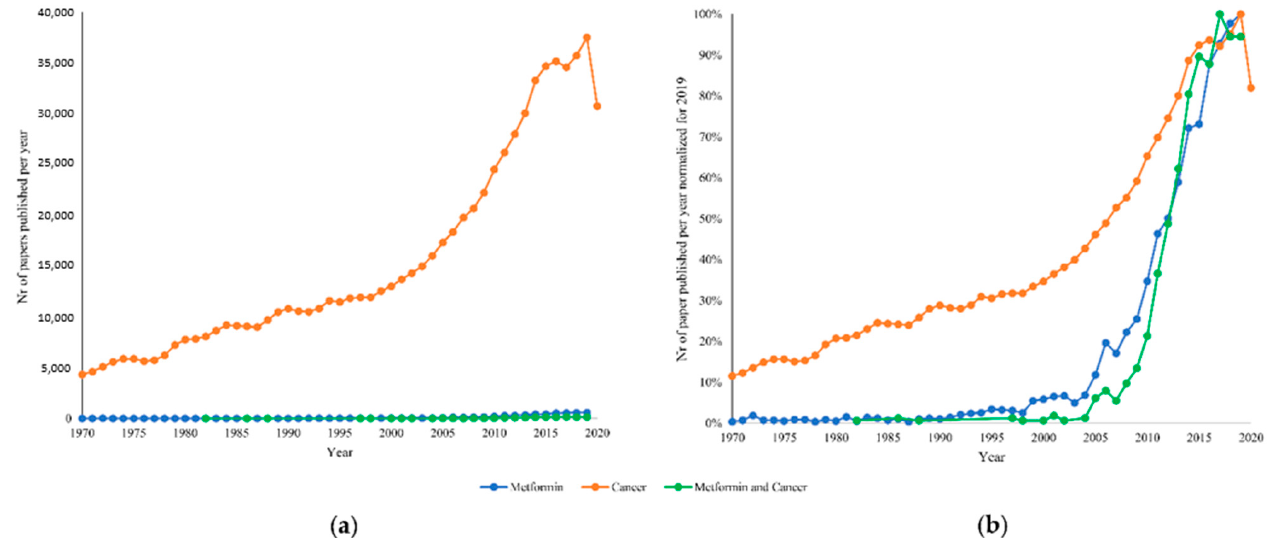
Figure 1. ( a ) The number (nr) of papers on experimental animals, published each year since 1970 and up to 2020, containing the terms “metformin”, “cancer”, and “metformin and cancer”. ( b ) The same data displayed as the ratio between the nr of papers published in each year divided by the corresponding feature in 2019. The steep increase in experimental studies dealing with metformin was associated with the interest in the anticancer potential of this drug.